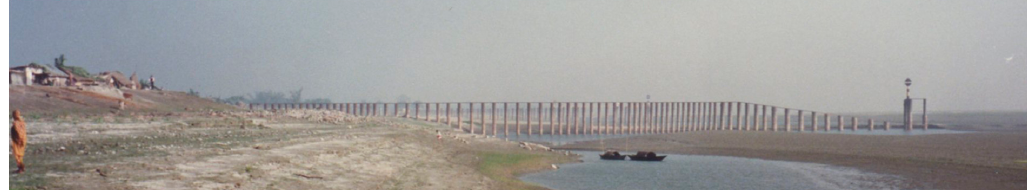
Figure 14. Groyne G-3 repaired and extended to the retired embankment during low water (photograph: project FAP 21/22).